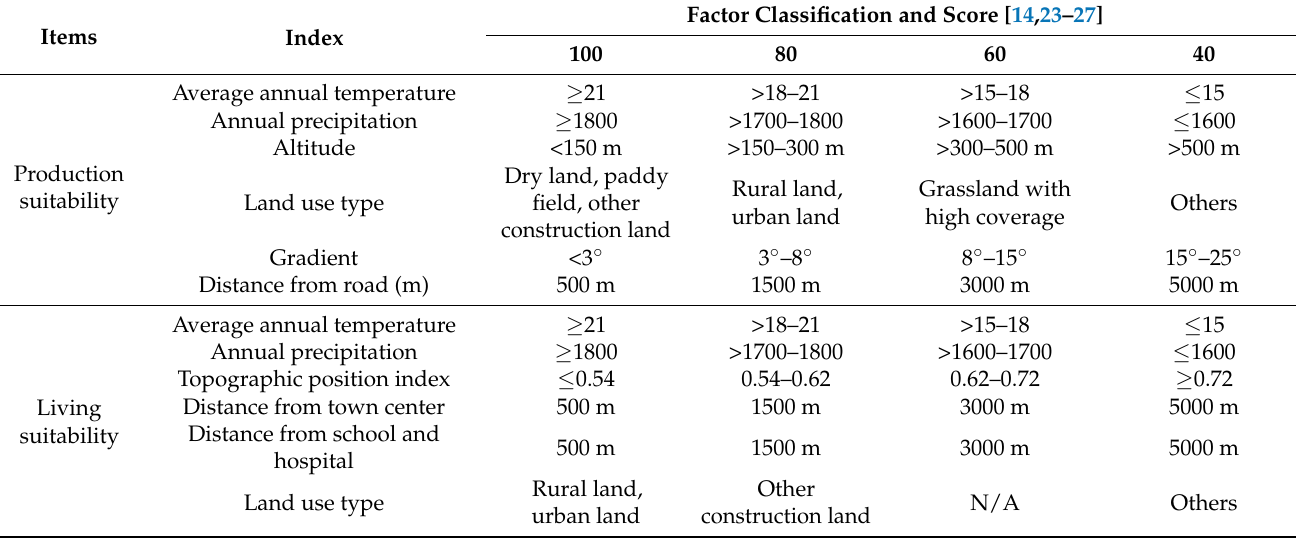
Table 2. Index system of PLES suitability